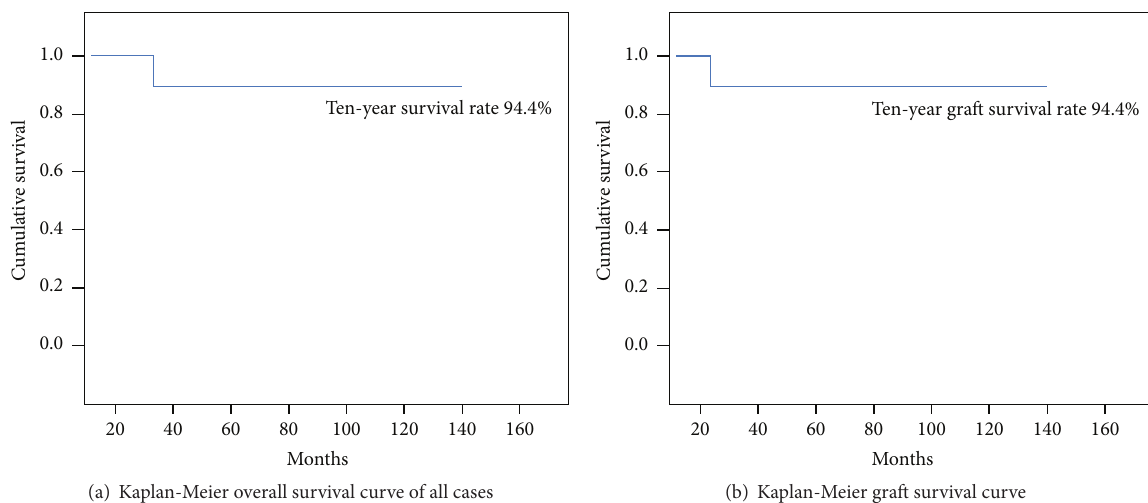
Figure 2: Survival curves. (a) Kaplan-Meier survival curve showing the five- and ten-year overall survival. (b) Kaplan-Meier survival curve showing the graft five and ten-year